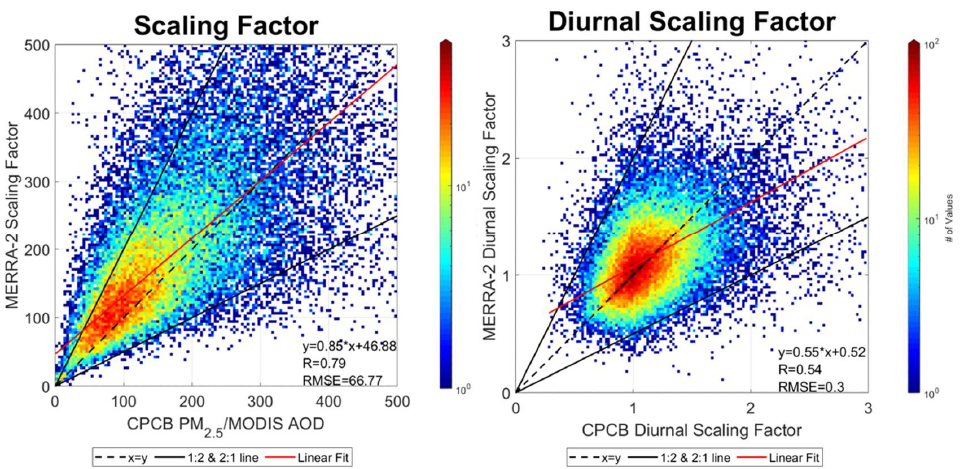
Figure 2. Regression statistics of the ( left ) scaling factor ( η ) and ( right ) diurnal scaling factor from MERRA-2 and ground-based measurements over India.